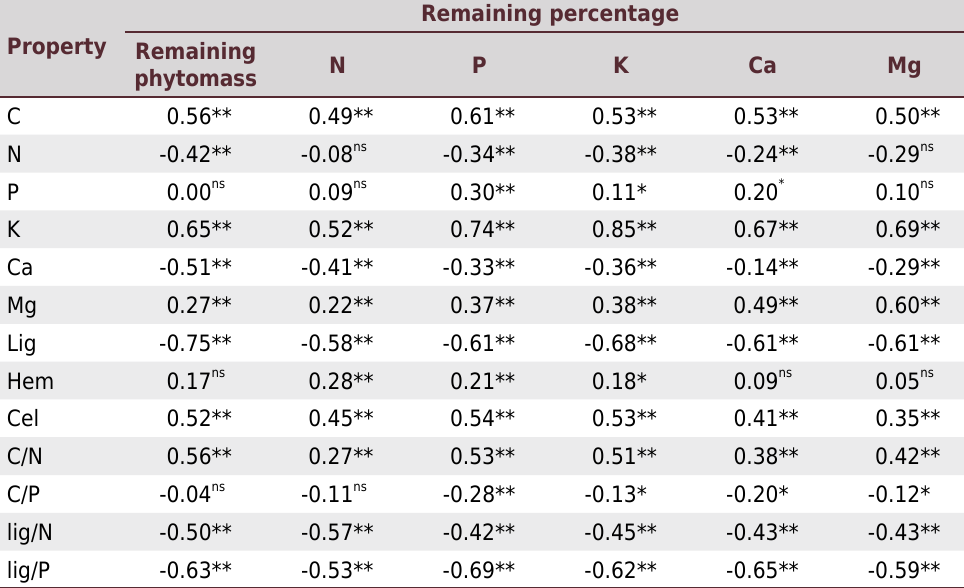
Table 5. Pearson correlation coefficients between percentage of phytomass and remaining nutrients, with some properties of the remaining dry phytomass over the time of decomposition